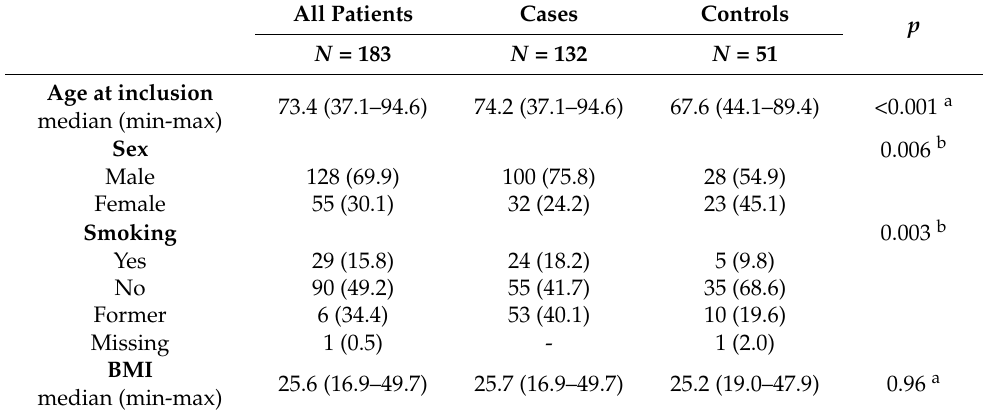
Table 1. Patient characteristics.